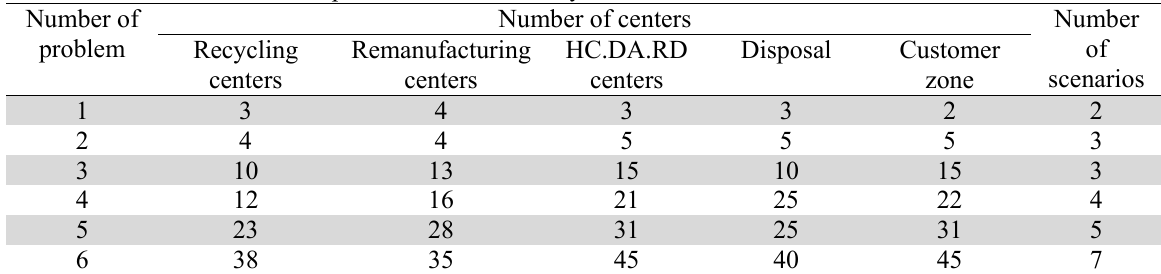
General information of the test problem to be solved by MATLAB software Number of problem